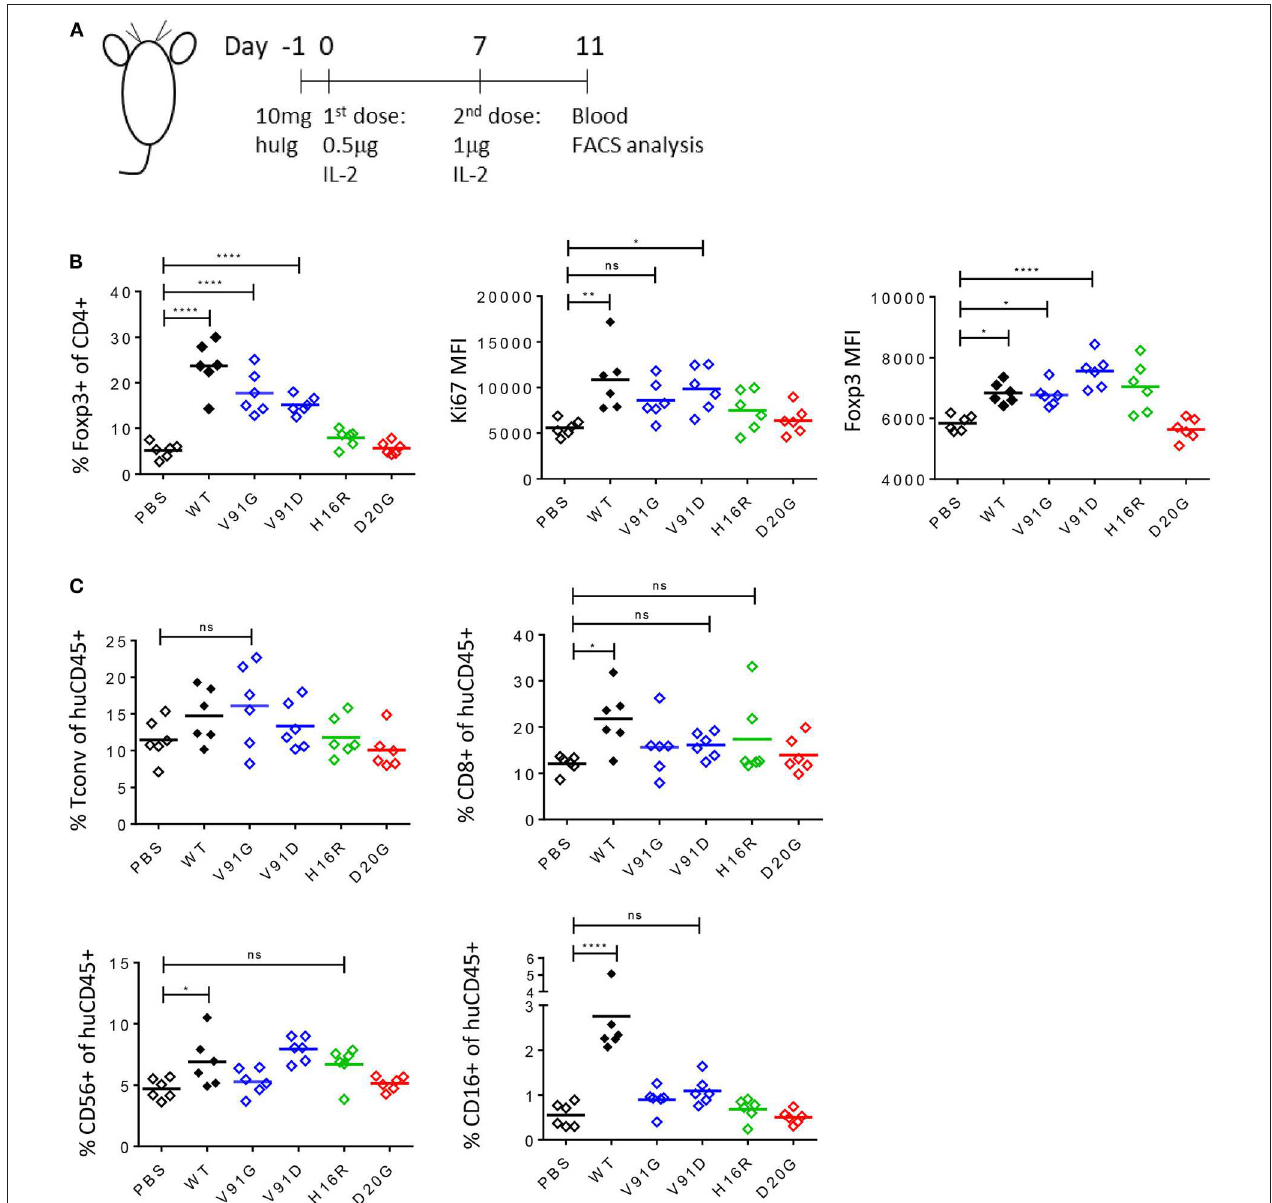
FIGURE 7 | Attenuated IL-2 muteins induce Treg cell expansion with enhanced Treg:NK selectivity in vivo . (A) Study design schematic. One day before the first dose, humanized NSG mice were treated with 10mg of human IgG. On day 0, wildtype IL-2 or IL-2 mutein was dosed s.c. at 0.5 µ g per mouse, followed by a boost on day 7 at 1 µ g per mouse. Blood was analyzed 4 days after the second dose, on day 11. Six animals per group were treated. Shown in the graphs, PBS-treated group served as vehicle control, and the muteins are color coded to represent class A (blue), B (green), and C (red). Ordinary one-way ANOVA analysis was performed to determine statistical significance of the comparisons between the wildtype- or IL-2 mutein-treated group and the PBS-treated group. (B) Attenuated IL-2 muteins induce human Treg cell response in vivo . Treg cells are gated based on Foxp3 expression and the representation of Treg cells are shown as percent of Foxp3 + in CD4T cells. The levels of Ki67 and Foxp3 expression on Treg cells are shown as Ki67 MFI and Foxp3 MFI, respectively. * p < 0.02; ** p < 0.0025; **** p < 0.0001. (C) The sizes of the various non-Treg cell compartments post IL-2 treatment are shown as percent of human CD45 + cells; Tconv (Foxp3– CD4T), CD8T, and CD56 + CD3– and CD16 + CD3– NK cell data are shown. * p < 0.04; **** p <